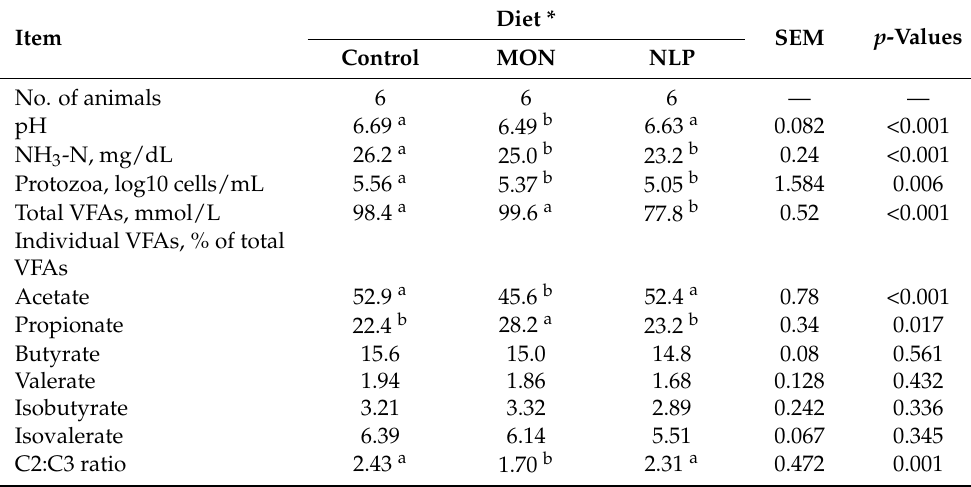
Table 4. Influence of neem leaf powder or monensin supplementation on ruminal fermentation constituents of Omani growing lambs.